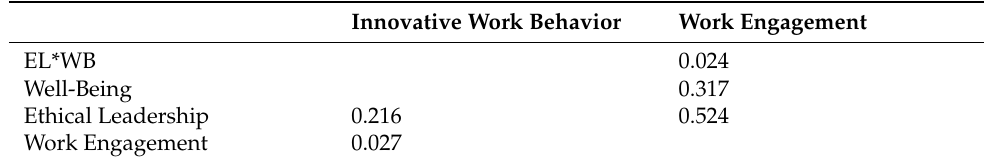
Table 6. Effect size f-square.